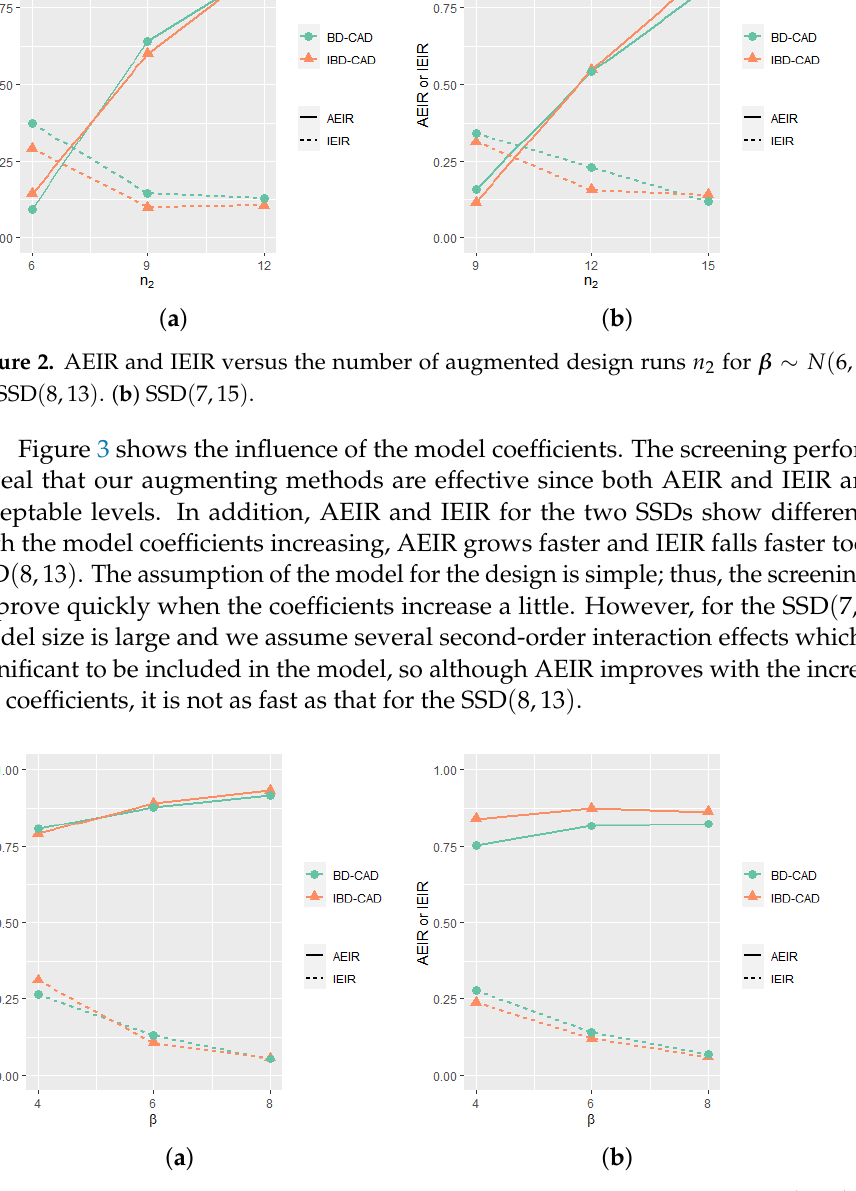
Figure 3. AEIR and IEIR versus the size of significant effects β for r = 2. ( a ) SSD ( 8,13 ) , n 2 = 12. ( b ) SSD ( 7,15 ) , n 2 =